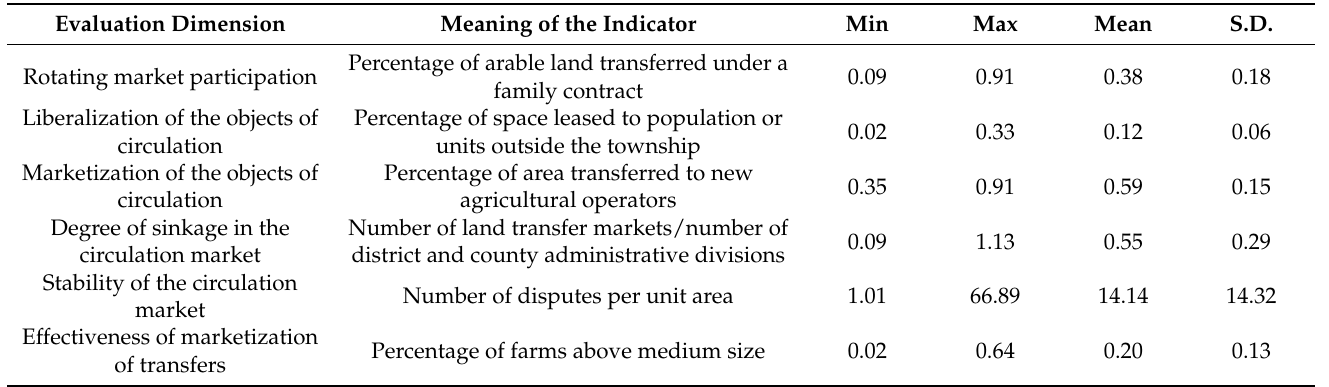
Table 7. Indicators of calculating the land transfer market